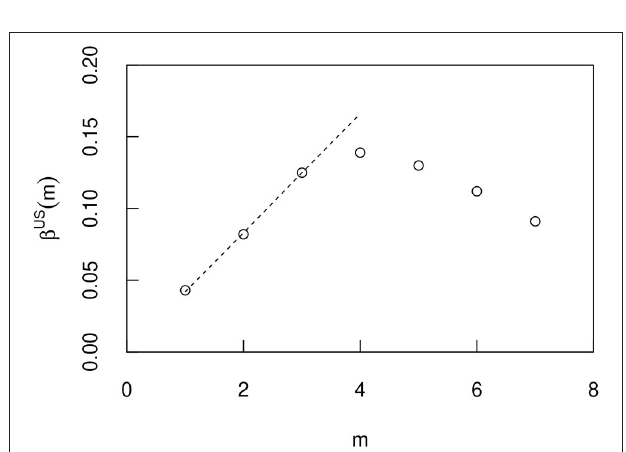
FIGURE 13 | The m dependence of the exponent β US ( m ) when the T dependence of the geometric mean h x T i is approximated by an exponential function e β US ( m ) T in a US simulation ( Figure 11 ). The errors are so small that they do not appear in the figure, and they are therefore omitted.